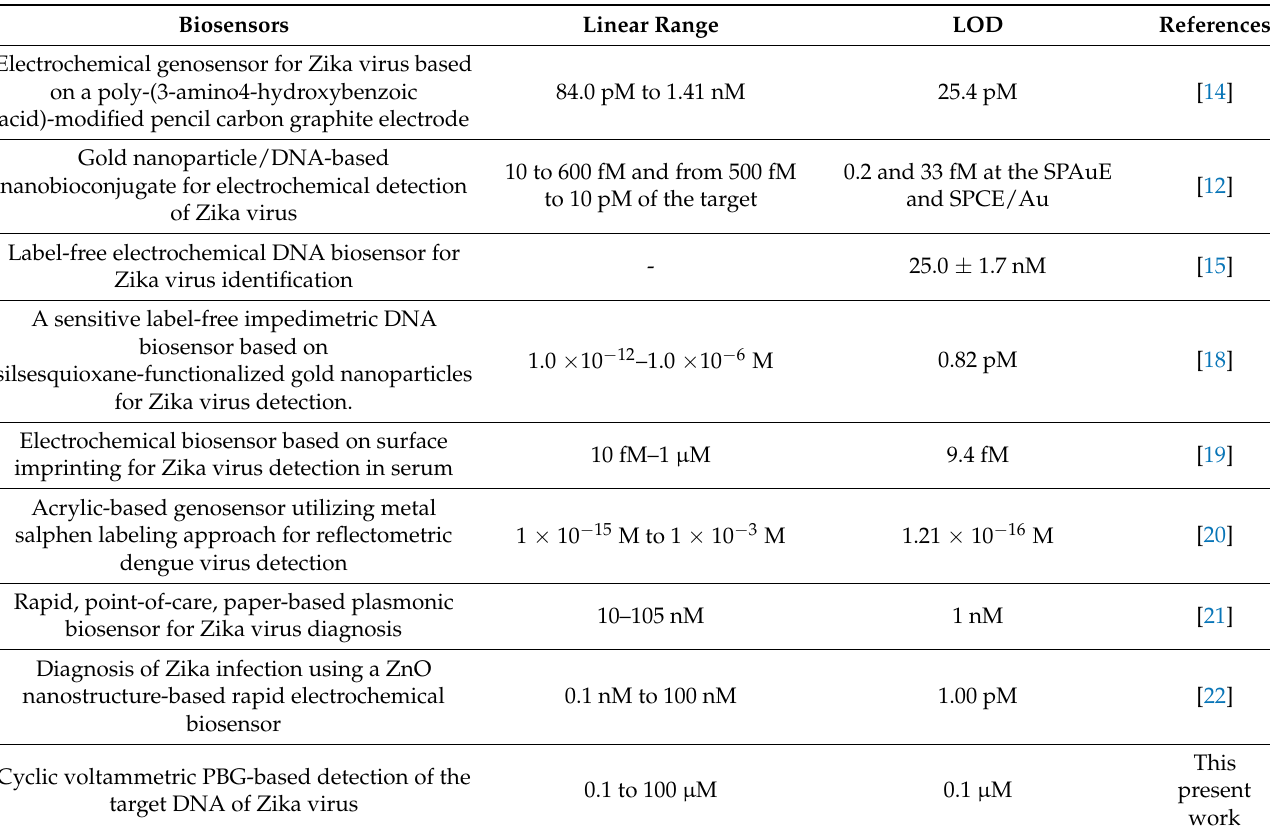
Table 2. Comparative study of various ZIKV-based